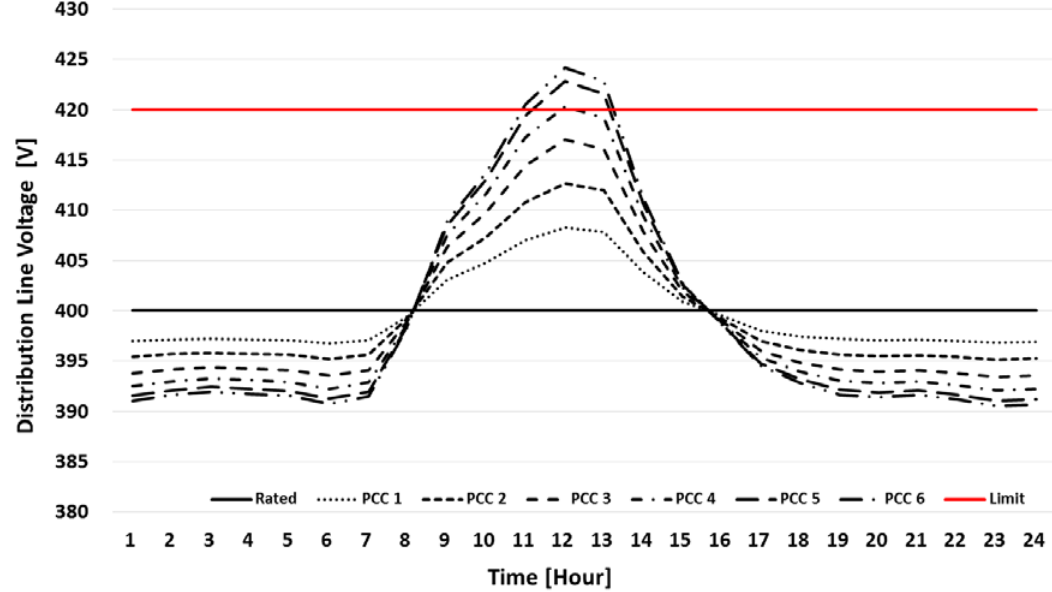
Figure 10. Voltage profile for one day (PV = 4